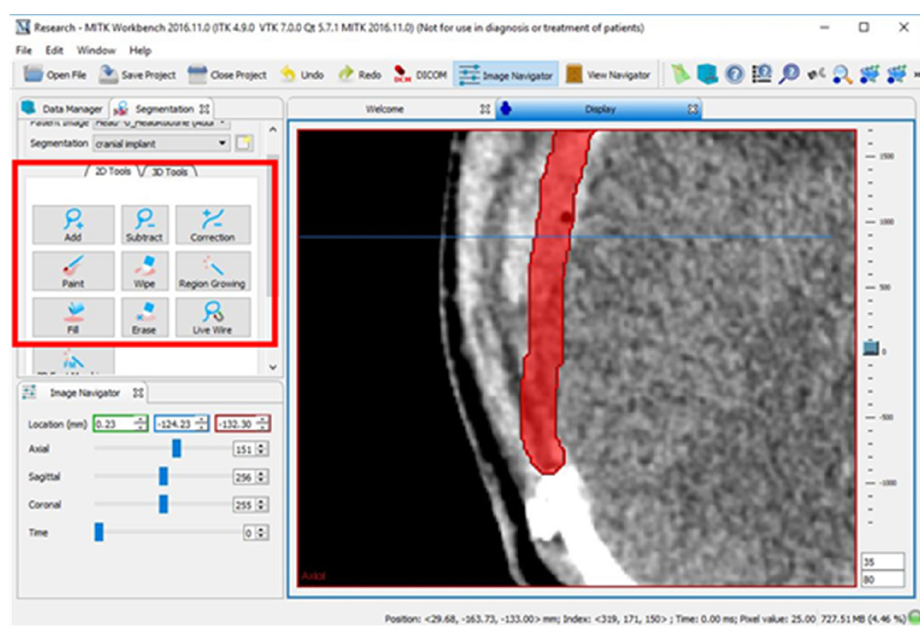
Figure 2. The “Paint” tool was used to draw the line along defective skull. The line was drawn while the left side of the mouse was held in a clicked position;